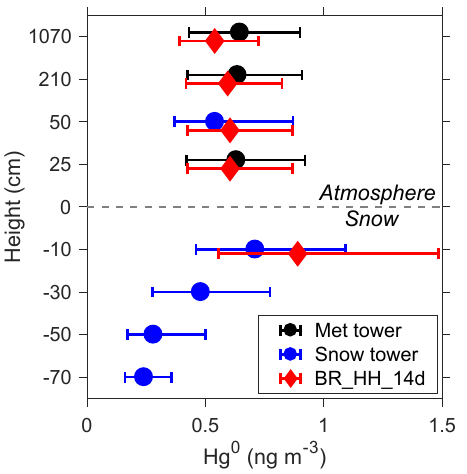
Figure 4. Summertime average Hg 0 concentrations at different heights from observations and model. The observations include the meteorological tower (25, 210, and 1070cm above the snow sur- face) and snow tower (50cm above the snow surface and 10, 30, 50, and 70cm below the snow surface). Model results from the BR_ HH_14d scenario are shown. Measurement data are from the snow tower no. 1 as reported in Angot et al. (2016c). Error bars indicate 25% and 75%